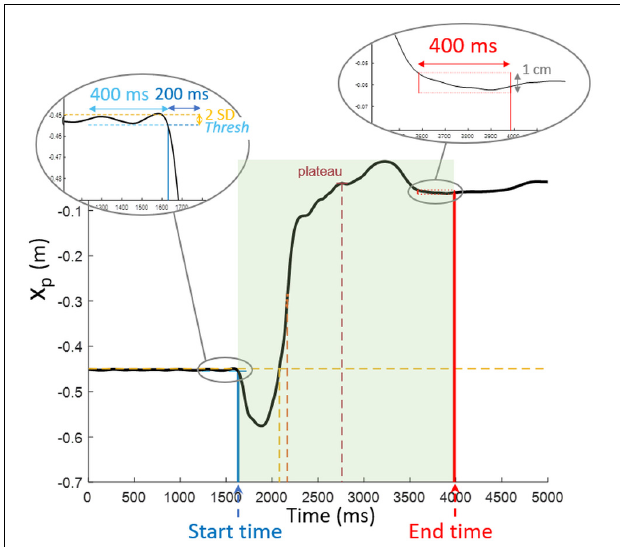
FIGURE 2 | Detection of start and end times. Start time corresponded to the fall of x p below the threshold calculated from the preceding 400 ms baseline for at least 200 ms. Concerning end time, the detection area was reduced to the time interval following the first plateau after feet loading, and end time preceded the first 400 ms where peak-to-peak CoP anteroposterior displacement did not exceed 1